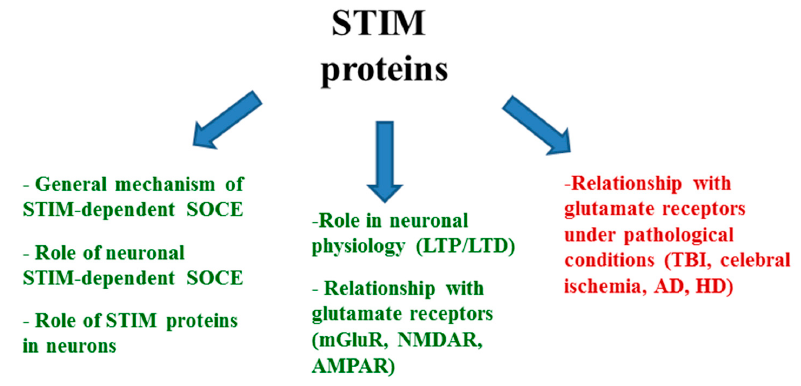
Figure 1. STIM proteins in neurons.